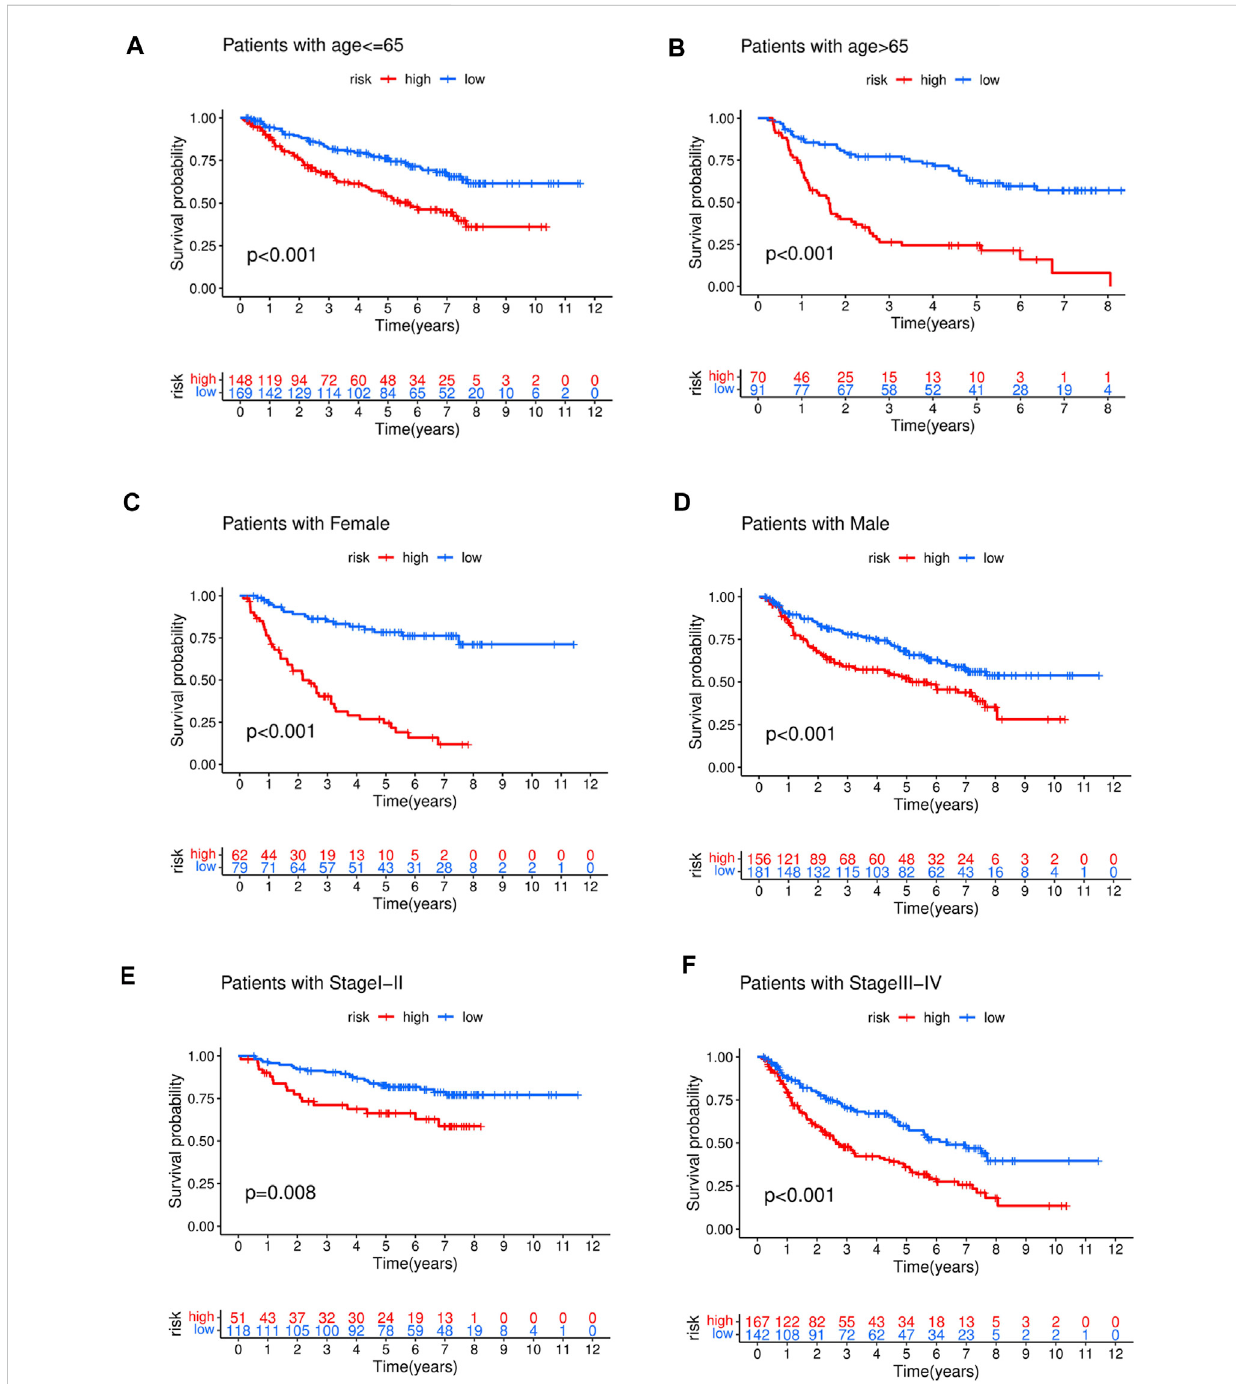
FIGURE 5 Thehigh-riskgroup intraining cohortshowedapoor prognosis thanthelow-risk groupindifferentclinicalstrati fi cation likeage (A,B) ,gender (C,D) , stage (E,F)